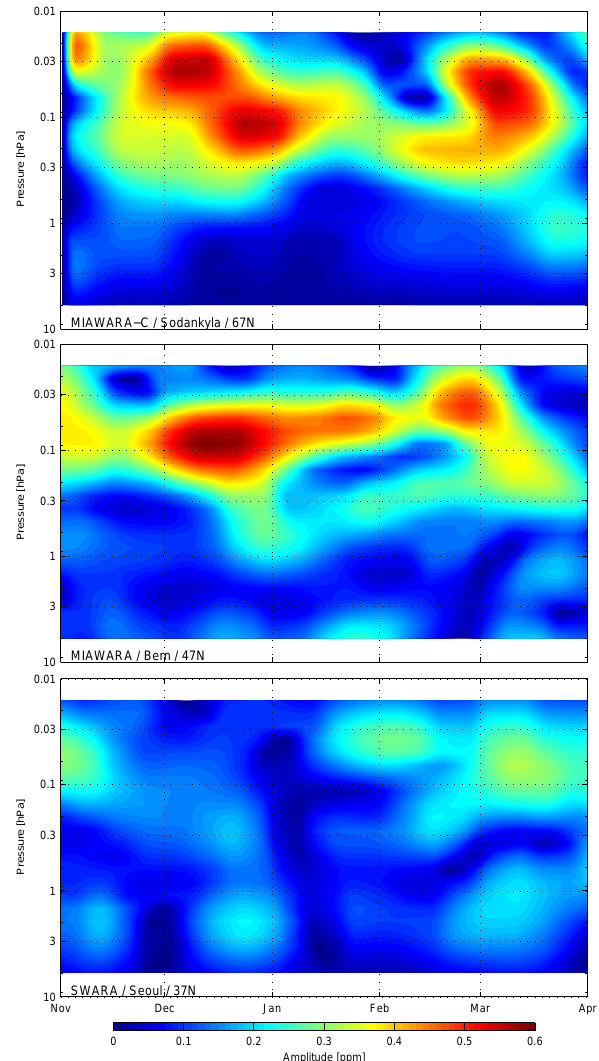
Figure 3. Amplitude of the bandpass-filtered water vapor time se- ries as observed by the three ground-based microwave radiometers Fig. 3. Amplitude of the bandpass filtered water vapor time series as observed by the three ground-based in Sodankylä, Bern and Seoul (from top to bottom). The lower and microwave radiometers in Sodankyl ¨ a, Bern and Seoul (from top to bottom). The lower and upper bandpass upper bandpass limits are 14 and 20 days, respectively. See descrip- tion within the text for details about the calculation limits are 14 and 20 days, respectively. See description within the text for details about the calculation method.